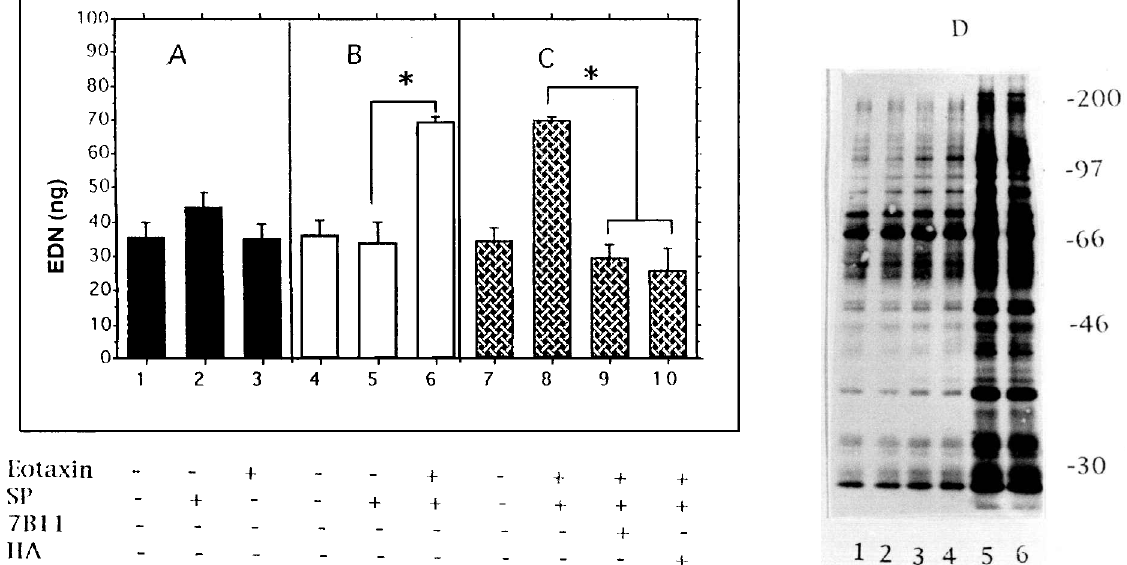
FIG. 1. Relationship between the priming activity of eotaxin in EDN release and tyrosine phosphorylation. (A) EDN secretagouge activity of 10 ng/ml eotaxin and 10 ± 8 M SP. Results are of a 1h degranulation assay and represent ± SEM of 6 independent experiments performed in duplicate. (B) Priming activity of 10 ng/ml eotaxin in EDN release stimulated by 10 ± 8 M SP. Asterisk indicates p =0.0001. Results are of 8 independent experiments performed in duplicate, ± SEM. (C) Modulation of eotaxin priming activity in EDN release by 7B11 and herbimycin A. Asterisk indicates p =0.0001. Results are of 6± 8 independent experiments performed in duplicate, ± SEM. (D) Association of tyrosine phosphorylation with CCR3 stimulation. Normal human eosinophils were pre-incubated for 15min at 37¡C with 10 ng/ml eotaxin (lanes 5 and 6) or for 15min with buffer only (lanes 3 and 4), cells were washed three times followed by 10 ± 8 M SP stimulation for a further 30min at 37¡C. Lanes 1 and 2 represent control cells stimulated with buffer only. Equal amounts of Triton X-100 cell lysates were analysed by western blotting with 4G10 mAb for phosphorylation. Molecular size markers are indicated on the right (kDa). Experiment shown is one representative of three independent experiments performed in